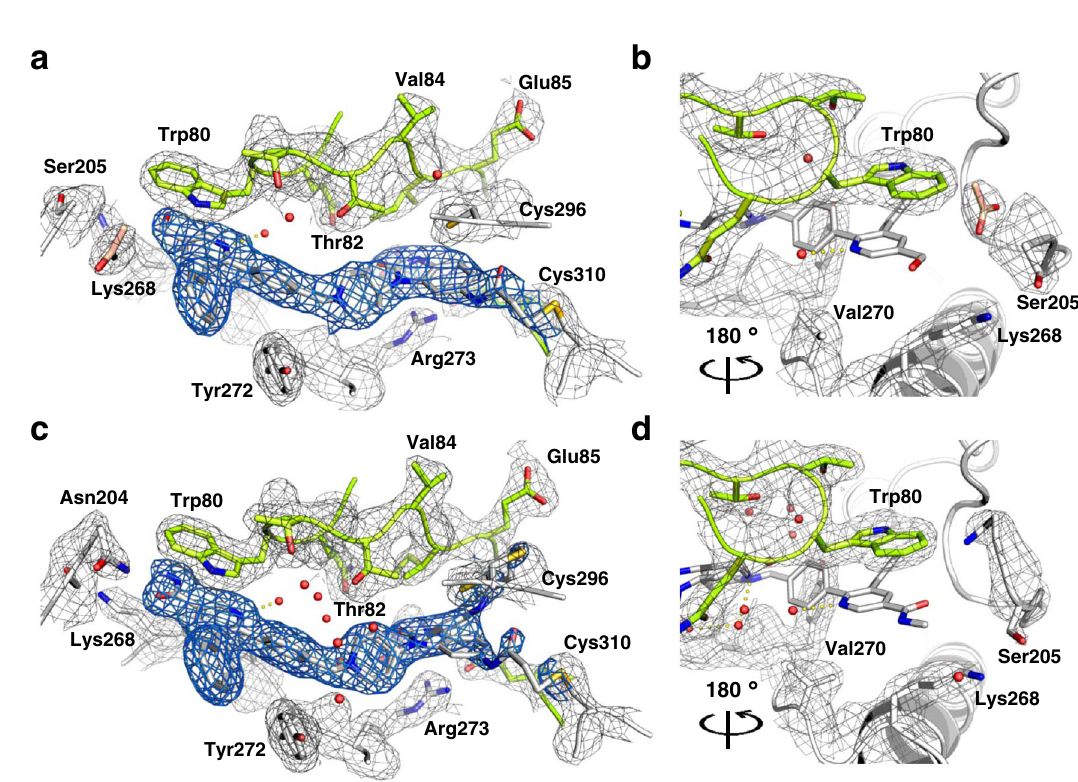
Fig. 3 Co-crystal structures of full-length Akt1 in complex with pyridine-based Akt1-selective CAAIs, 2F O − F C maps contoured at 1.0 σ . a , b Co-crystal structure of Akt1 with 3 (PDB: 7NH4). The electron density indicates possible covalent bond formation with both Cys296 and Cys310 but suggests preferred modi fi cation of Cys310 (see F O -F C simulated annealing omit map in Supplementary Fig. 13).; c , d Co-crystal structure of Akt1 with 6 (PDB: 7NH5). The electron density suggested two alternative compound conformations presumably forming a covalent bond with either Cys296 or Cys310 (see F O − F C simulated annealing omit maps in Supplementary Fig.